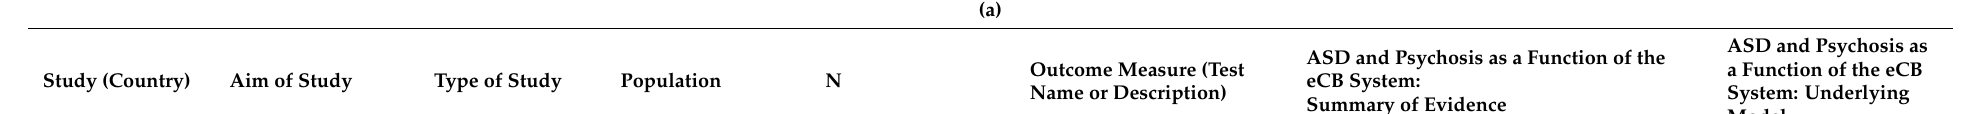
Table 1. ( a ). Summary of animal studies investigating ASD and psychosis as a function of the eCB system. ( b ). Summary of human studies investigating ASD and psychosis as a function of the eCB